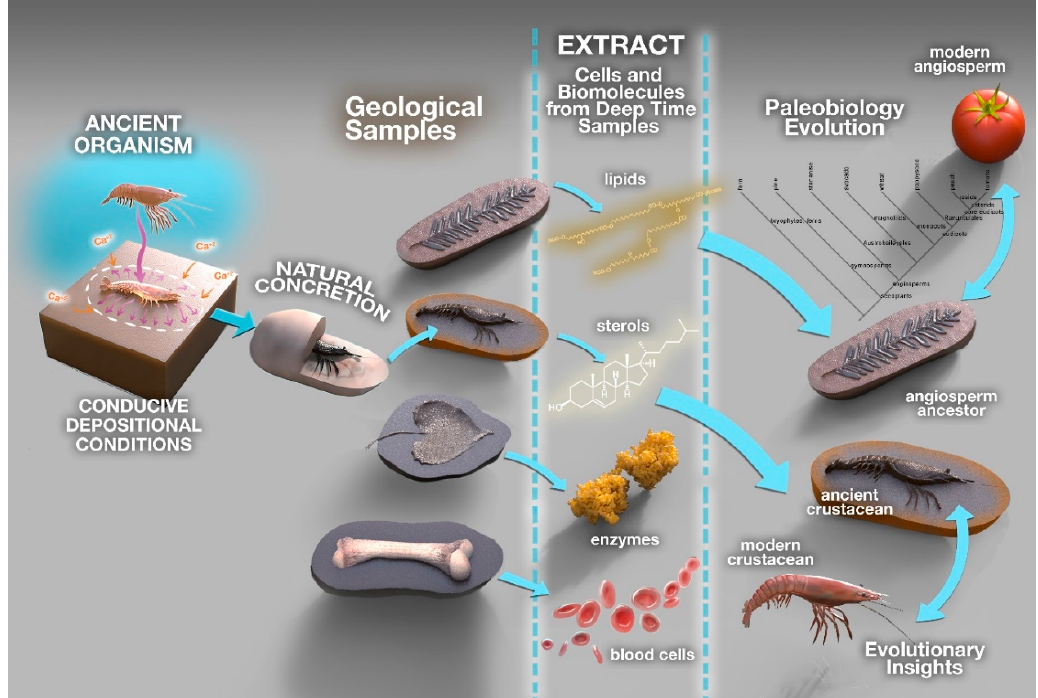
Figure 1. Studies of exceptionally preserved fossils provide information on the links between modern and ancient organisms, e.g., References